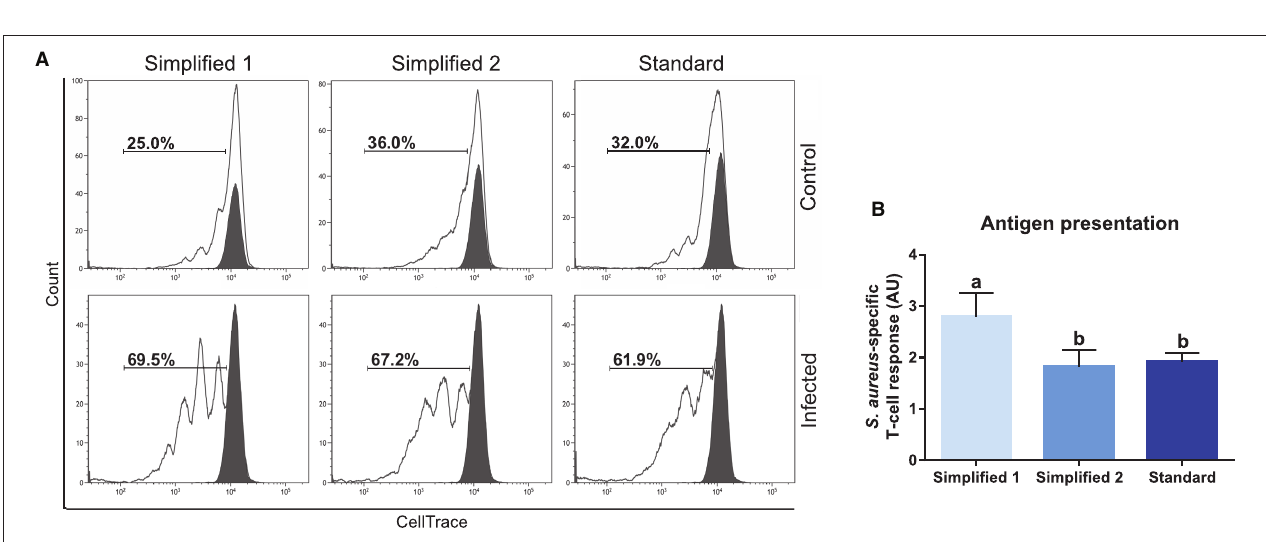
FIGURE 7 | Analysis of phagocytosis capacity by flow cytometry. (A) White, red, and black peaks correspond to mock control, pHrodo beads alone, and moDC pulsed with pHrodo, respectively. Upon phagocytosis, pHrodo beads are exposed to acidic pH and have their fluorescence levels increased. The histogram shows the results of one representative experiment. (B) Dot plot shows non-phagocytic (green) and phagocytic (black) cells. The percentage of cells in the indicated gate corresponds to the percentage of phagocytosis. (C) The bar plot depicts the percentage of phagocytosis in samples from three different animals. Different letters mean statistically significant difference ( p < 0.05). Error bars represent SD.